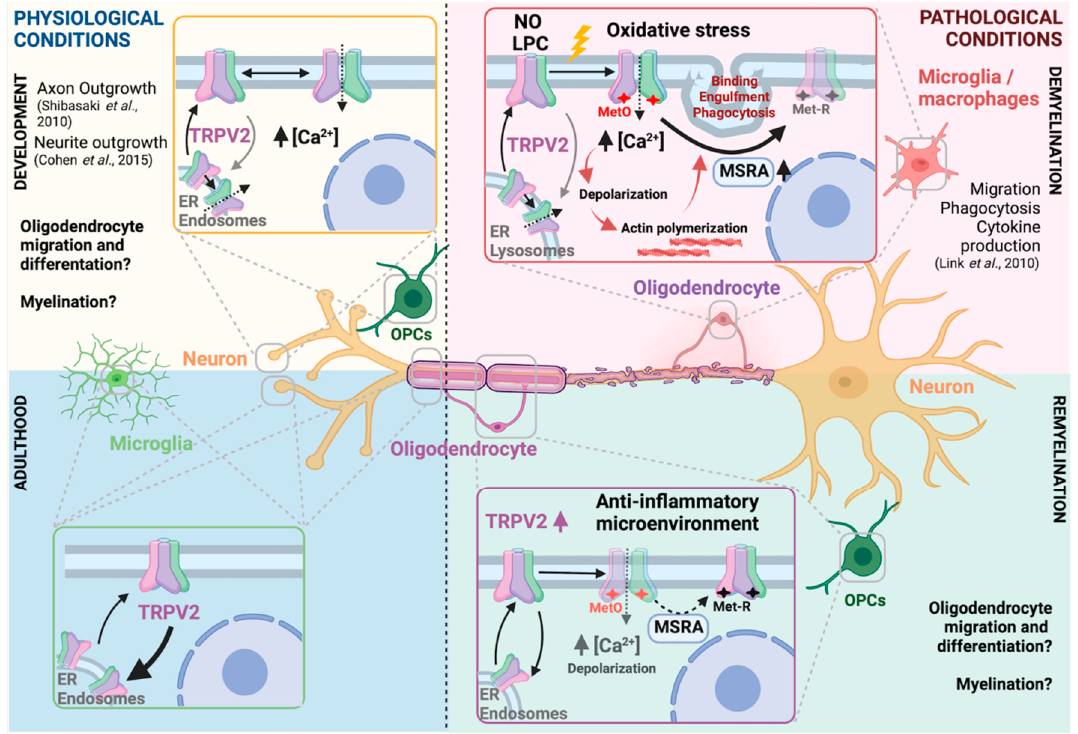
Figure 7. TRPV2-centered cellular cross-talk model in physiological and pathophysiological myelination. During embryonic development, TRPV2 develops an essential role in neurite and axon outgrowth. In that period, TRPV2 is known to be expressed and activated in neurons, and putatively in OPCs, where possible cross-talk between both cells might be triggered through TRPV2 activation. In adulthood, TRPV2 expression is found in microglia, neurons and oligodendrocytes. Upon an insult such as demyelination, TRPV2, as a non-selective ion channel, is activated. Some known triggering stimuli are NO, LPC or oxidative stress, the latter causing methionine oxidation which facilitates TRPV2 sensitization. TRPV2 activation promotes a sodium/calcium inward influx from extracellular media and/or ER or endosomes. Consequently, cells are depolarized, which initiate processes such as actin polymerization or phagocytosis in microglia or innate immune cells. In those cells, TRPV2 has been involved in migration, phagocytosis or cytokine production. TRPV2 inactivation is promoted by MSRA enzyme, by reducing oxidized methionine. In our results, we observed both an increase of TRPV2 and MSRA in demyelinating scenarios. During remyelination, OPCs proliferate and migrate to the demyelinated area, where they differentiate through several stages to mature oligodendrocytes, and start myelination. Our results showed increased TRPV2 expression during this period. Overall, ubiquitous TRPV2 expression and activation in de- and remyelinating processes suggest a multicellular cross-talk that promotes myelin repair at all levels. TRPV2 is relevant in development and demyelination, making this model suitable for the recapitulation hypotheses. Created with BioRender.com.